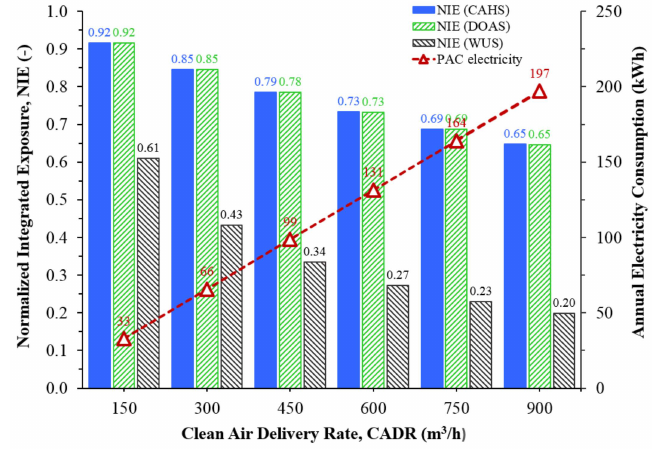
Figure 9. Effect of portable air cleaner (PAC) on the NIE of the three HVAC systems (CAHS, DOAS, and WUS) for 3 h per day of continuous exposure and associated annual electricity consumption.